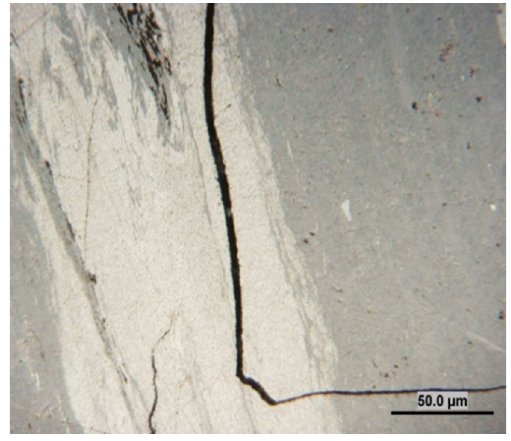
Fig. 2 Collotelinite passing gradually into the collodetrinite with dispersed sporinite, macrinite, fusinite and inertodetrinite